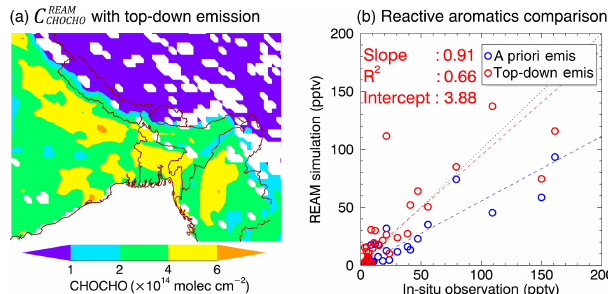
Figure 4. REAM-simulated CHOCHO VCDs with top-down emis- sions (a) and comparison of simulated and observed reactive aro- matic concentrations during period 2 (b) . Blue and red circles in panel (b) represent REAM simulation with a priori (slope = 0.56, R 2 = 0 . 83) and with top-down (slope = 0.91, R 2 = 0 . 66) emis- sions, respectively.